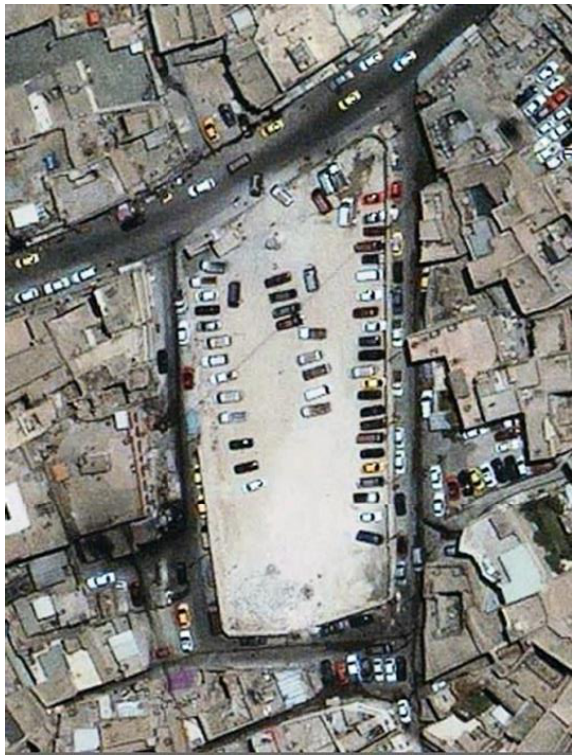
Figure 8. Complex of the mosque dedicated in 1300 to the Prophet Nabi Jirijs in Nineveh before the events